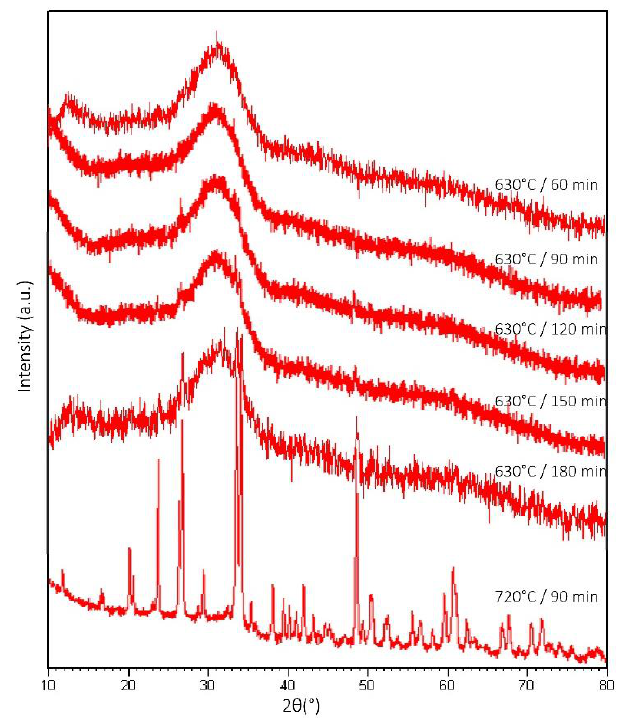
Figure 2. XRD analysis of S53P4 scaffolds sintered for 60 to 180 min at 630 °C and 90 min at 720 °C. A.U. refers to arbitrary units.